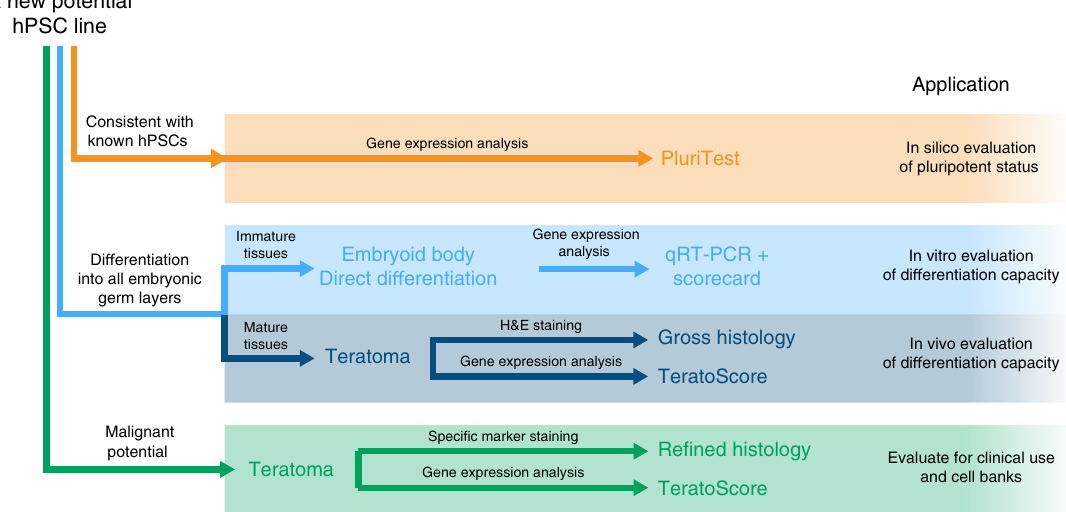
Fig. 6 Proposed strategy to analyze new human pluripotent stem cell lines depends on the information required. To fi rst determine whether or not a cell line is pluripotent (orange lines), its signature can be compared to that of known pluripotent cells ’ signatures using PluriTest. To con fi rm whether that cell line (blue lines), is capable of differentiating into derivatives of all three embryonic germ layers in vitro embryoid body (EB) formation in ‘ neutral ’ differentiation conditions, or by speci fi c lineage-promoting differentiation conditions, combined with bioinformatic scorecard analysis, should be suf fi cient. If necessary differentiation to speci fi c mature cells types may be also assessed in vivo by xenografting and teratoma formation followed by either histological analysis or RNA-seq analysis using Teratoscore. But to evaluate whether the cell line in question might have malignant potential (green lines) careful examination of histological sections of the teratoma using antibodies to speci fi c markers or by focusing the RNA-seq and TeratoScore on speci fi c markers associated with a malignant phenotype is